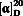
Reaction between cyclic aminal 6 and p-substituted phenols 7a-l.